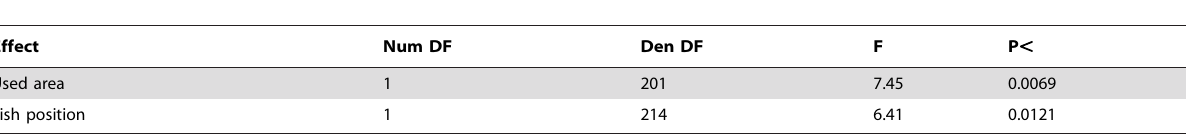
Table 3. Type 3 tests of fixed effects for final LMM